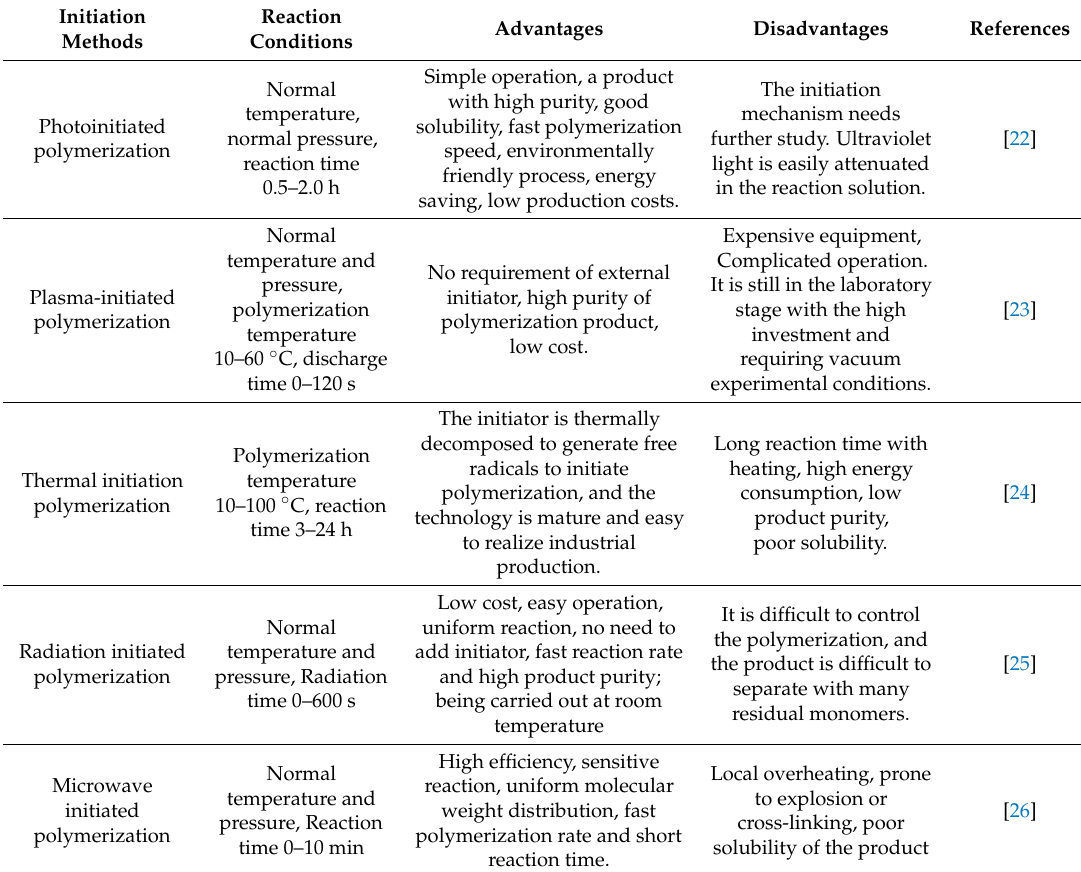
Figure 1. Possible scheme of CCPAD synthesis. Table 2. Comparisons of initiation techniques to induce graft-polymerization.